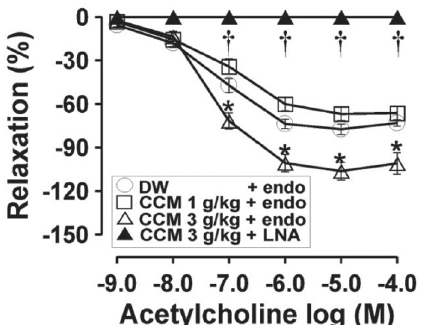
FIGURE 4 - Effect of 6 weeks oral gavage of CCM(1 or 3 g/kg) or distilled water (DW, control) on relaxation of the endothelium-intact thoracic aortic ring precontracted with phenylephrine to acetylcholine before and after pre-incubation with L-NA (CCM 3 g/kg+L-NA). Values represent mean ± SEM; n=6. *Significantly lower than the other groups and † significantly higher than the other groups, P< 0.05.